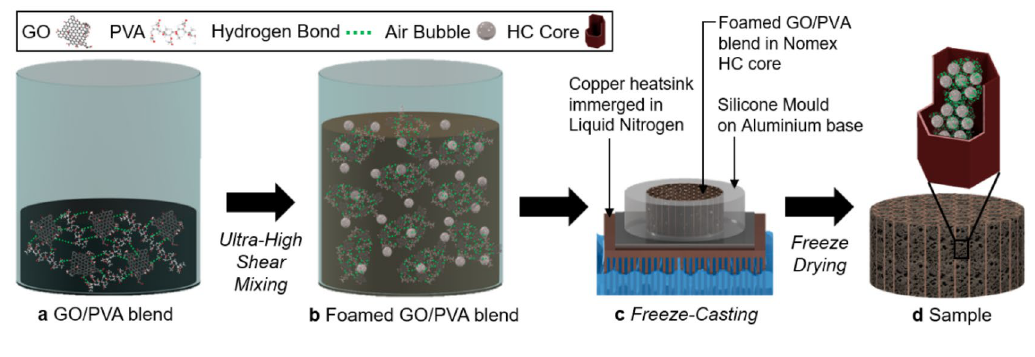
Figure 1. Schematic illustration of the ultralight